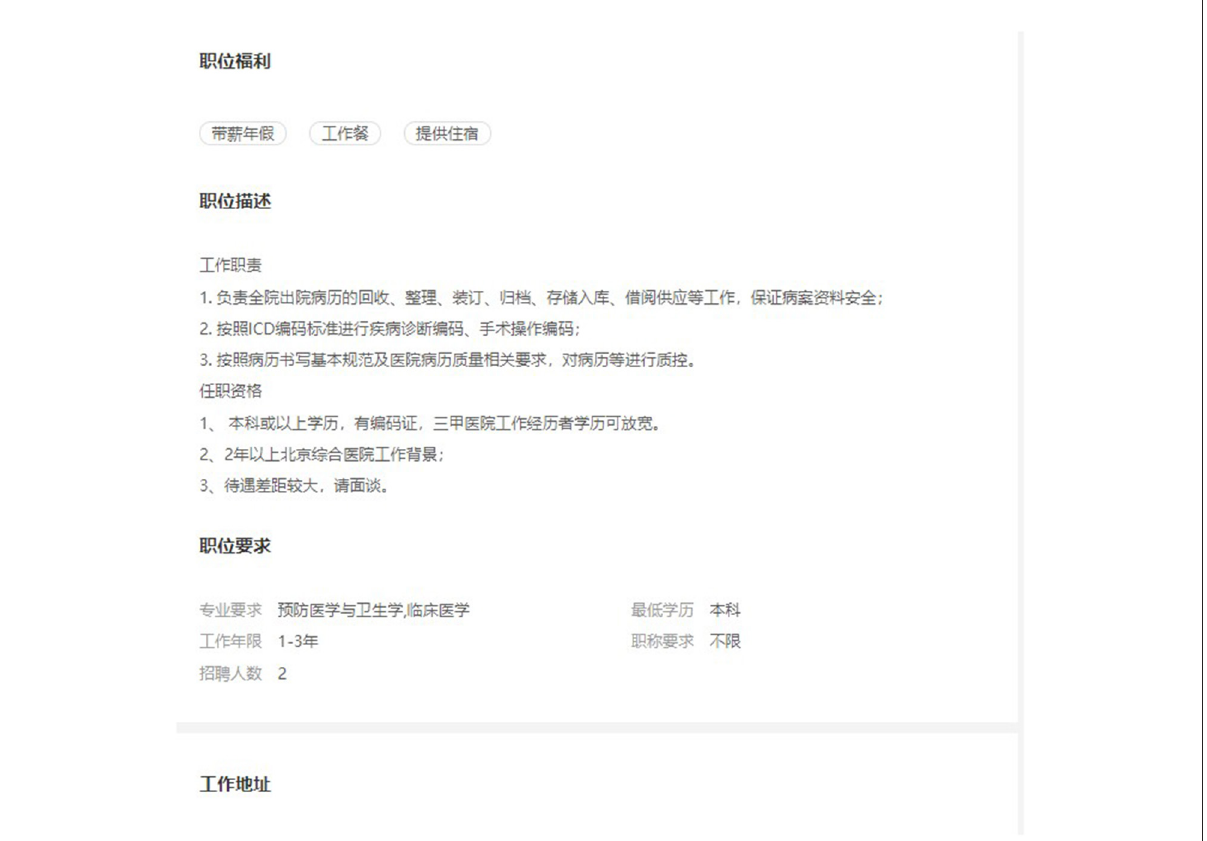
FIGURE2 Example of original job advertisement (Edited in 2022/6, China).